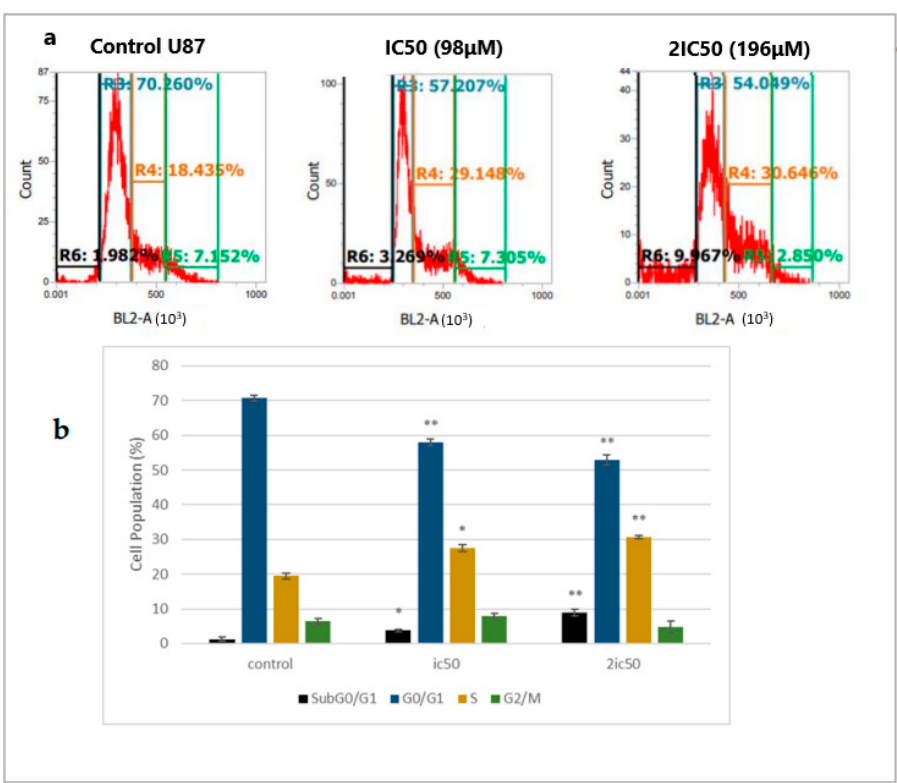
Figure 5. The regulatory effect of linearol on cell cycle distribution in U87 cells. ( a ) Linearol at concentrations of 98 and 196 µ M increased the S and SubG0/G1 populations 72 h post-treatment. ( b ) Cell cycle distribution of U87 cells after treatment with linearol and PI staining at 72 h. Cell populations at different cell cycle phases were quantified and data were expressed as mean ± SD from 3 different experiments. * p < 0.05; ** p < 0.001 .